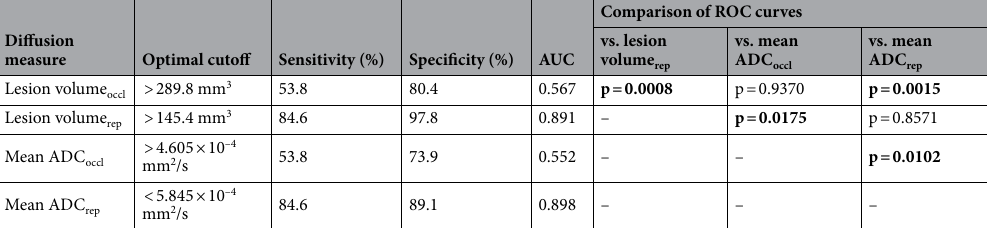
Table 2. ROC curve analysis of the diffusion measures. ROC receiver operating characteristic, ADC apparent diffusion coefficient, Optimal cutoff closest to the upper left corner of the ROC space, AUC area under the curve, lesion volume occl./rep. lesion volume determined based on ADC map during occlusion/at reperfusion, mean ADC occl./rep. mean ADC of the initial lesion site during occlusion/at reperfusion; Sensitivities and specificities are reported at the optimal cutoff values for identification of animals dying prematurely. p-values were obtained from pairwise comparison of ROC curves by DeLong test. p-values in bold indicates significantly different AUCs.